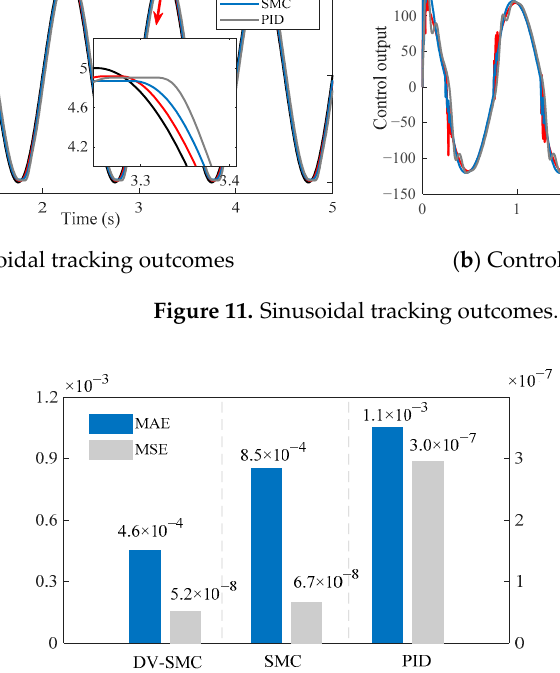
Figure 12. Tracking error of different controllers.